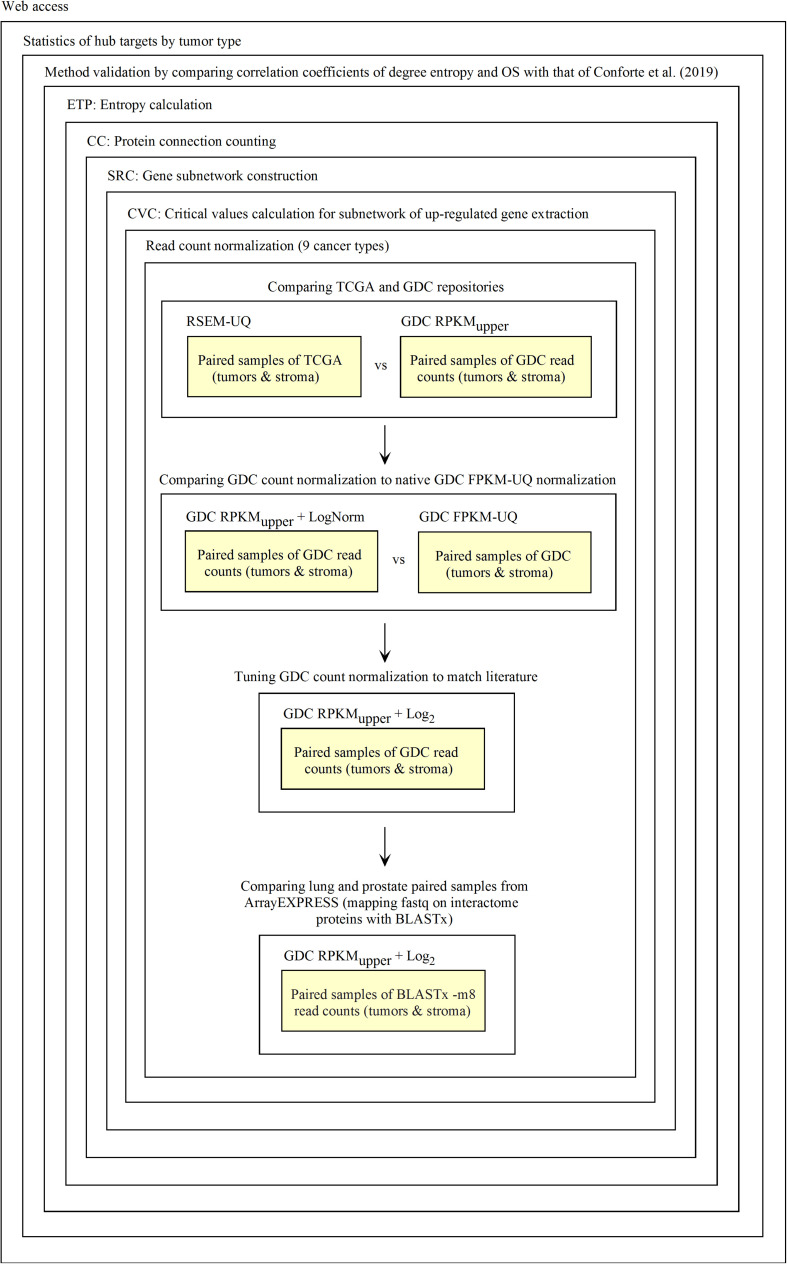
Process of Galaxy workflow validation.